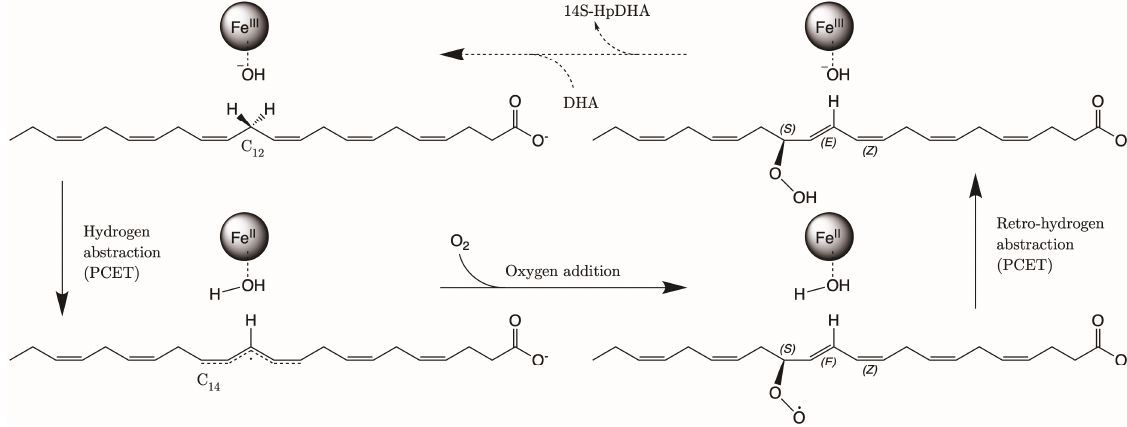
Figure 11. Scheme of the DHA hydroperoxidation mechanism. PCET stands for proton coupled electron transfer.